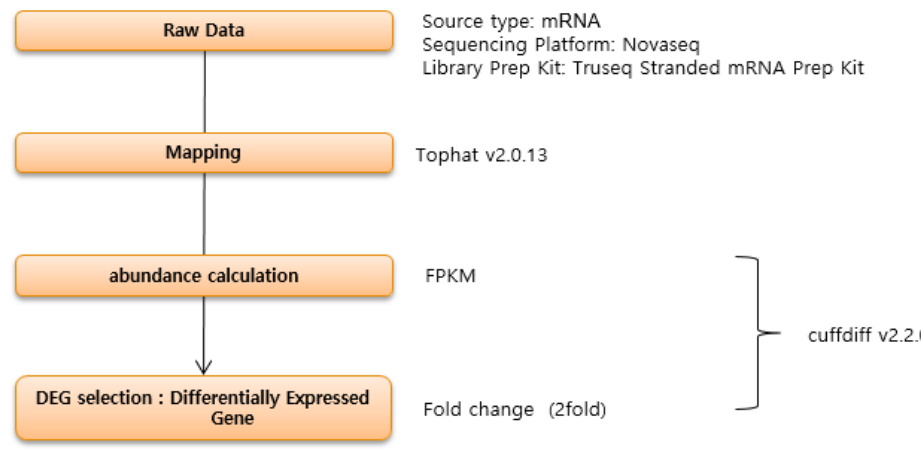
Figure 6. Flow chart of mRNA